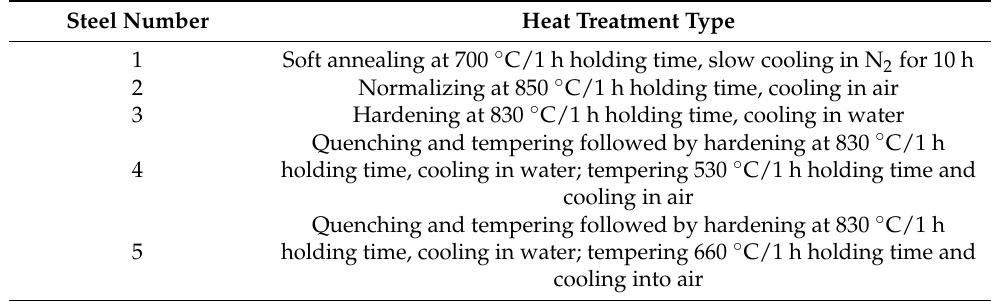
Table 2. Heat treatment parameters of C45 steel.